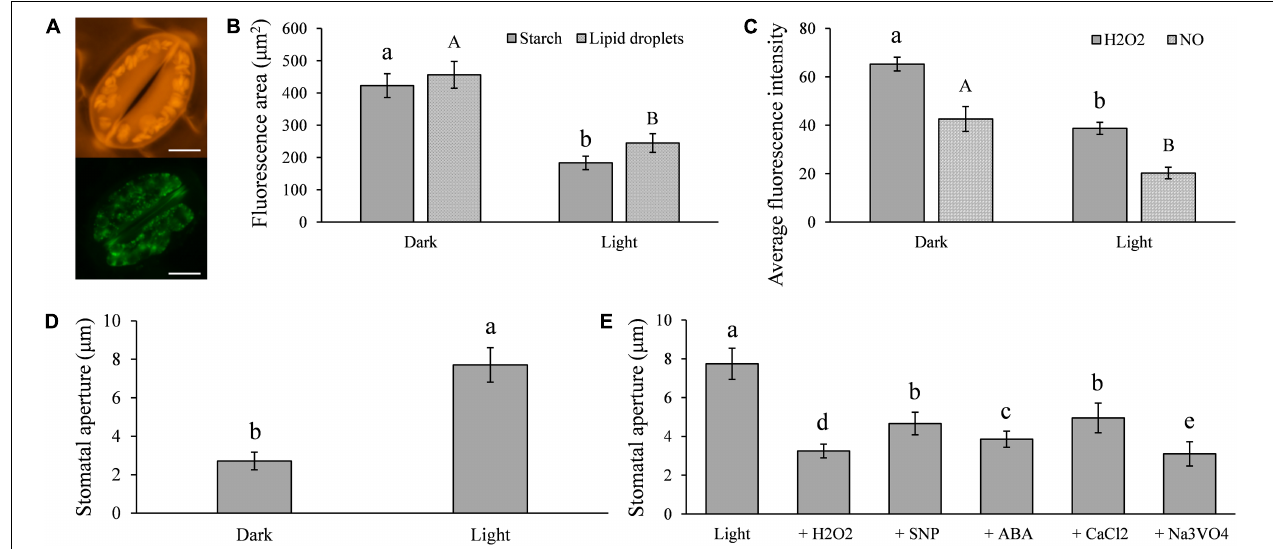
FIGURE 1 | Light-induced stomatal opening in potato is associated with the metabolisms of triacylglycerols (TAGs), starches, H 2 O 2 , NO, ABA, CaCl 2 , and plasma membrane H + -ATPase in guard cells: (A) images showing potato guard cells containing a large amount of starch (up) and TAGs (below); (B) compared with the results seen in dark conditions, the quantities of starch and TAGs in guard cells were significantly less in light (100 µ mol/m 2 /s 1 for 6 h); (C) H 2 O 2 and NO contents in guard cells were significantly decreased in light compared with those in dark conditions; (D) the size of stomatal aperture significantly increased in light compared with those in dark conditions; and (E) light-induced stomatal opening was impaired by the artificial supplement of 2 µ M H 2 O 2 , 1 µ M NO, 10 µ M ABA, 5 mM CaCl 2 , and 1 mM Na 3 VO 4 . The marker = 20 µ m. Photos within a panel are from a representative of a single replicate while photos among panels are pooled from multiple replicates.